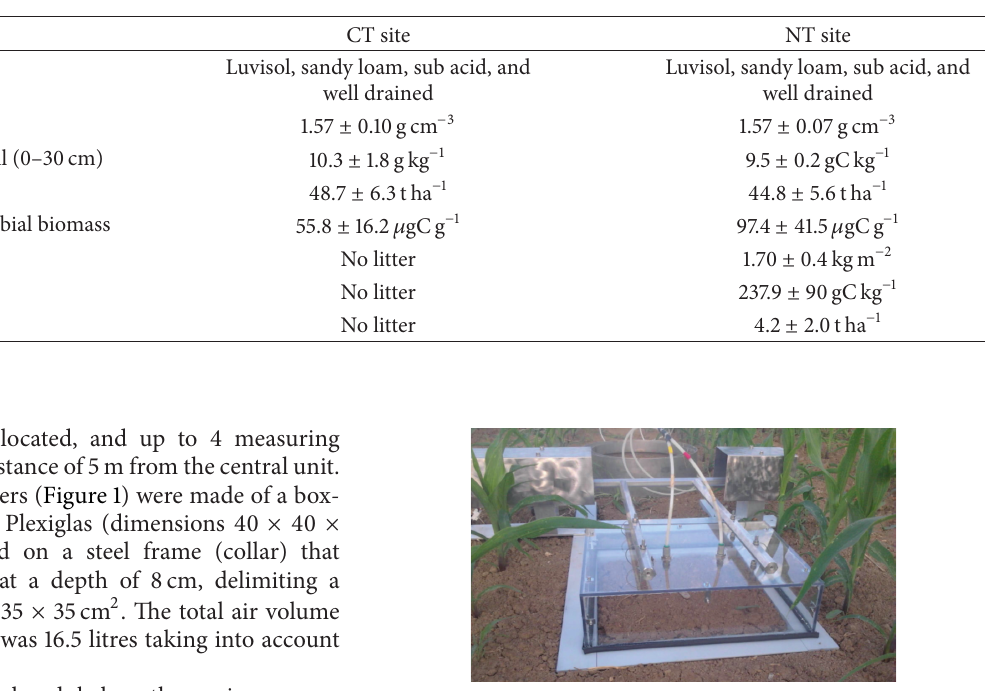
Table 2: Soil and litter organic carbon content in the two experimental sites. In both sites, soil type was Luvisol, sandy loam, subacid, and well drained. CT = conventional tillage site; NT = no-tillage site.